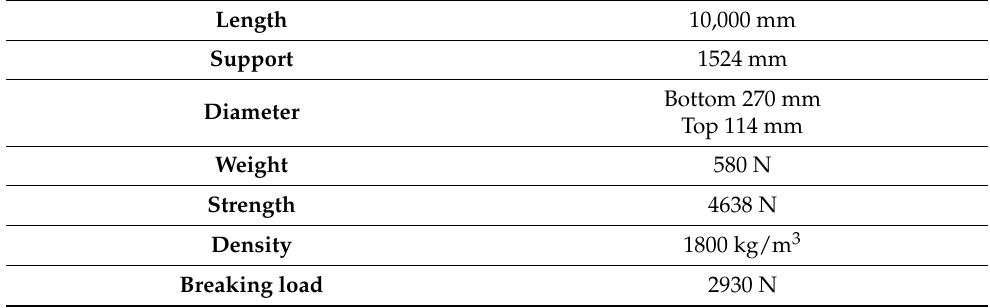
Table 5. FRP pole specification.